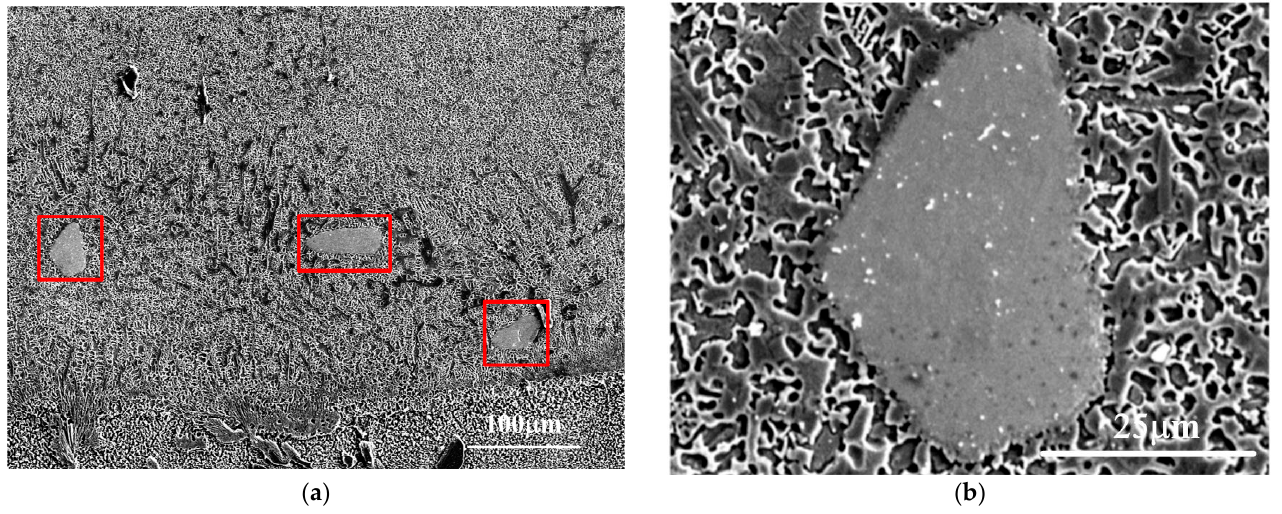
Figure 8. Bulk hard phase in the bottom of the coating: ( a ) distribution of the bulk hard phase (Red squares indicate the hard phase at the bottom of the coating); ( b ) magnified bulk hard phase.